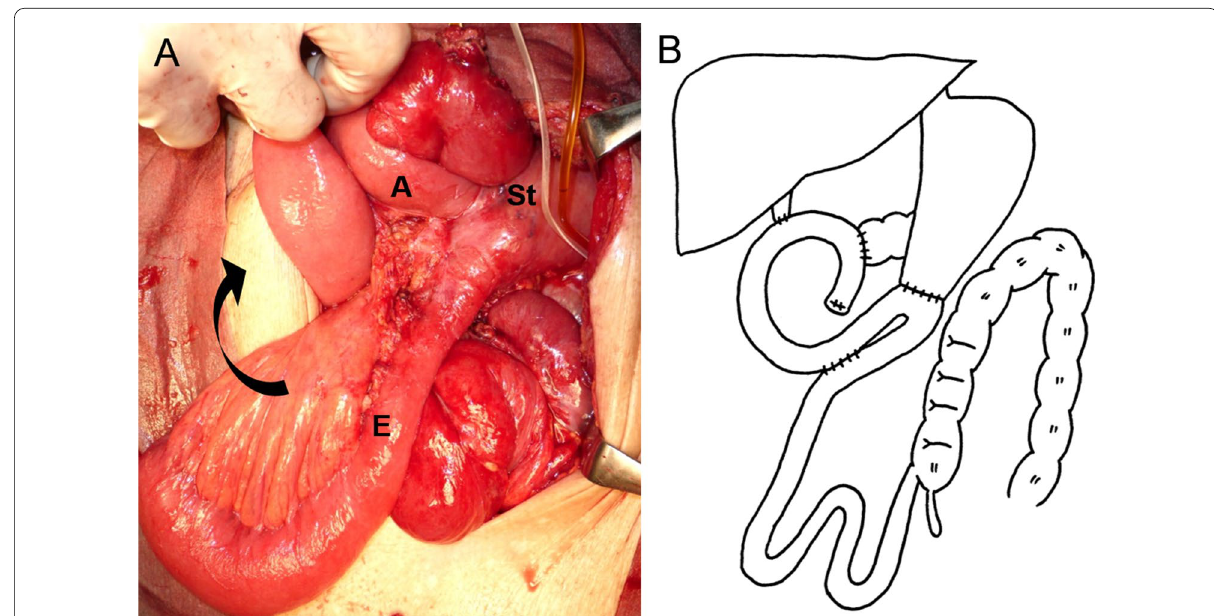
Fig. 4 Findings of the reoperation. a After detorsion, the efferent loop had twisted 180° in the clockwise direction and was adherent to the right upper abdominal wall (black arrow). b Braun anastomosis was performed to prevent efferent loop twisting and maintain its continuity inferiorly. A, afferent loop; E, efferent loop; St,